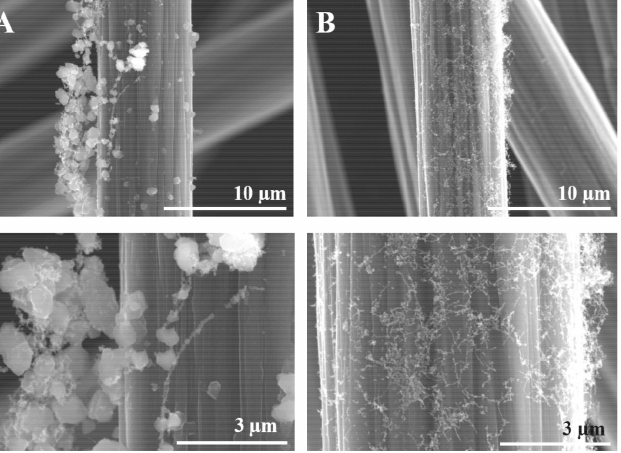
Figure 9. Effect of sizing on PLD of SWCNTs on carbon fibres: ( A ) desized fibres, and ( B ) sized fibres.